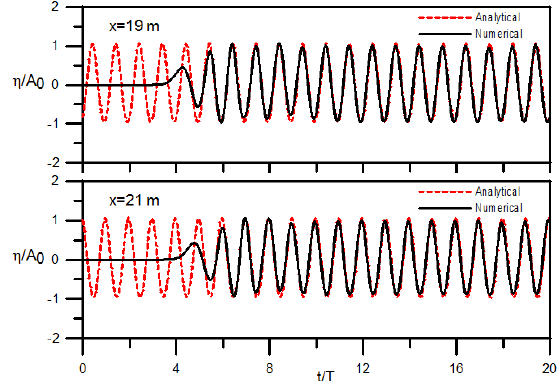
Figure 3. Simulation results of the surface elevation for linear progressive waves at the two gauge stations of x = 19 m ( upper ) and x = 21 m ( lower ) with the incident wave amplitude H i = 0.02 m and period T = 2 s.